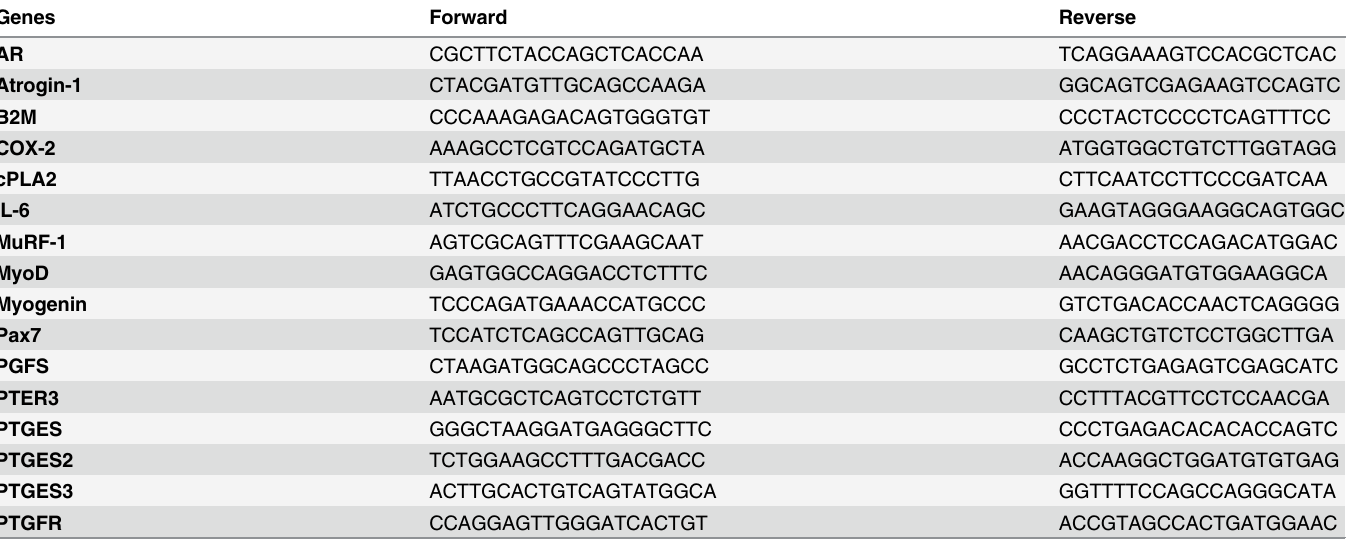
Table 2. Sequence of primers used in real-time polymerase chain